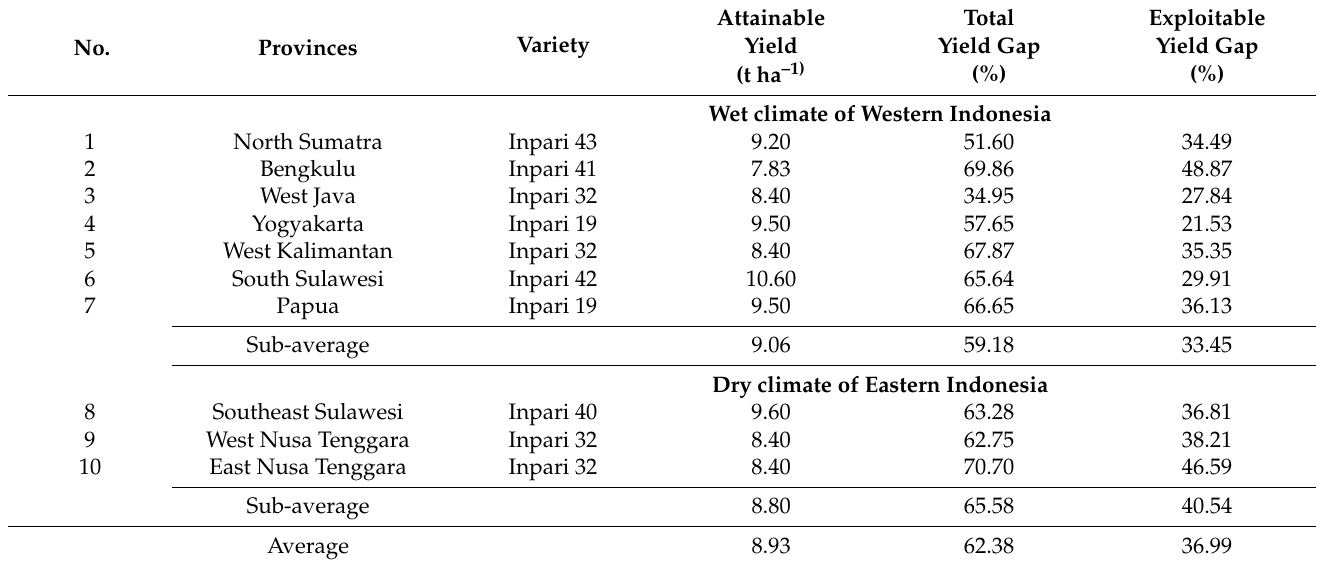
Table 7. Disaggregated attainable yield, total yield gap and exploitable yield gap in rainfed lowlands in the wet climate of western Indonesia and the dry climate of eastern Indonesia, DS